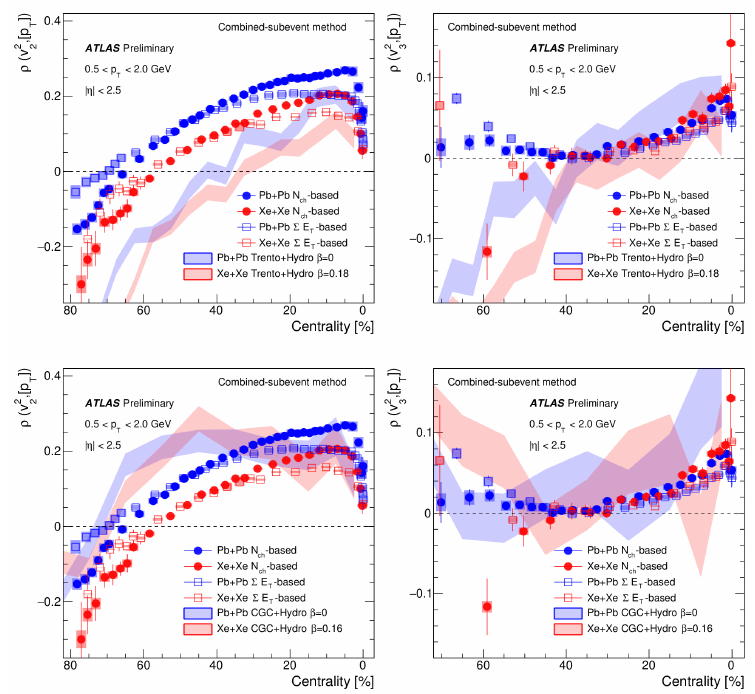
]) (left) and ρ ( v 2 ]) (right) as a function of the collisions cen- Figure 1: ρ ( v 2 , [ p , [ p T T 2 3 trality in Pb + Pb (blue symbols) and Xe + Xe (red symbols) collisions obtained using N ch -based (closed symbols) and Σ E -based (open symbols) event averaging proce- T rec < 2 GeV [ 5 ] . They are compared with a hy- dure for charged particles in 0.5 < p T drodynamical model calculation based on Trento initial condition [ 6 ] (top) and with a calculation based on a three-dimensional initial condition dynamically generated from gluon saturation models [ 7 ] (bottom). The error bars and boxes on the data points regard statistical and systematic uncertainties, respectively. The width of the bands represent the statistical uncertainties of the